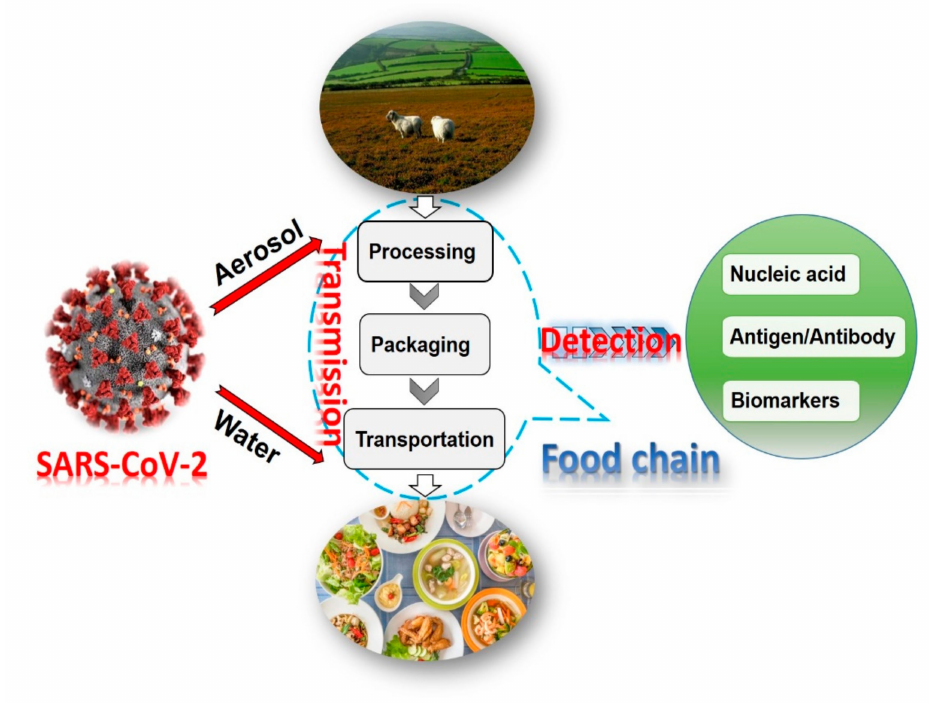
Figure 1. Schematics for the critical stages of the food supply chain from farm to table and methods for detection of severe acute respiratory syndrome coronavirus-2 (SARS-CoV-2)